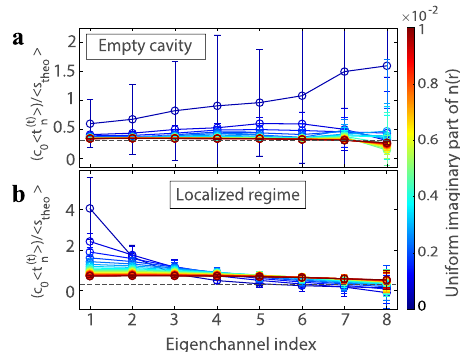
Fig. 3 In fl uence of absorption. a , b Normalized transmission eigenchannel contribution to the mean path length as a function of the index n , where n = 1 ( n = 8) corresponds to the highest (lowest) transmitting eigenchannel for the empty sample ( a ) and a localized sample ( b ). Increasing absorption leads to a redistribution of the transmission time- delays which all converge to the length of the most direct path in the limit of strong absorption (see Supplementary Note 4). The horizontal black dashed line marks an estimation of the most direct path in the empty system. Error bars represent the standard deviation of the channel delay 050100150200250 times in transmission for each eigenchannel. Number of Fig. 2 Mean path lengths with respect to the number of scatterers. a Mean path length evaluated as 〈 s (2 Q t ) 〉 , see Eq. (1), obtained in simulations without (black crosses) and with (black circles) absorption as a function of the number of metallic cylinders within the cavity. The red solid line is the theoretical length calculated from the Weyl law (see Eq. (2)). Absorption reduces the estimated mean path length. Background colors in rose, green, and white mark the localized, diffusive, and the ballistic regime as in Fig. 1b. b The same quantity, 〈 s (2 Q t ) 〉 , found experimentally (blue circles). The squares and triangles are the mean path length in transmission and in re fl ection, respectively (see Supplementary Note 1 for details). Error bars represent the standard